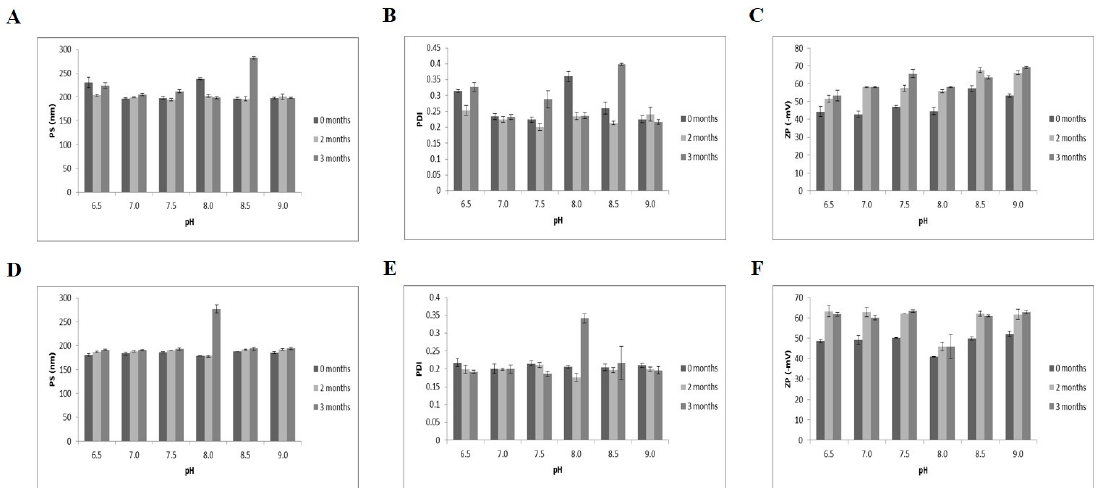
Figure 2. Physical stability of quercetin-loaded nanoemulsions for 3 months. ( A – C ) nanoemulsion storage at 21 °C; ( D – F ) storage at 37 °C. PDI, Polydispersity index; PS, particle size; ZP, zeta potential.